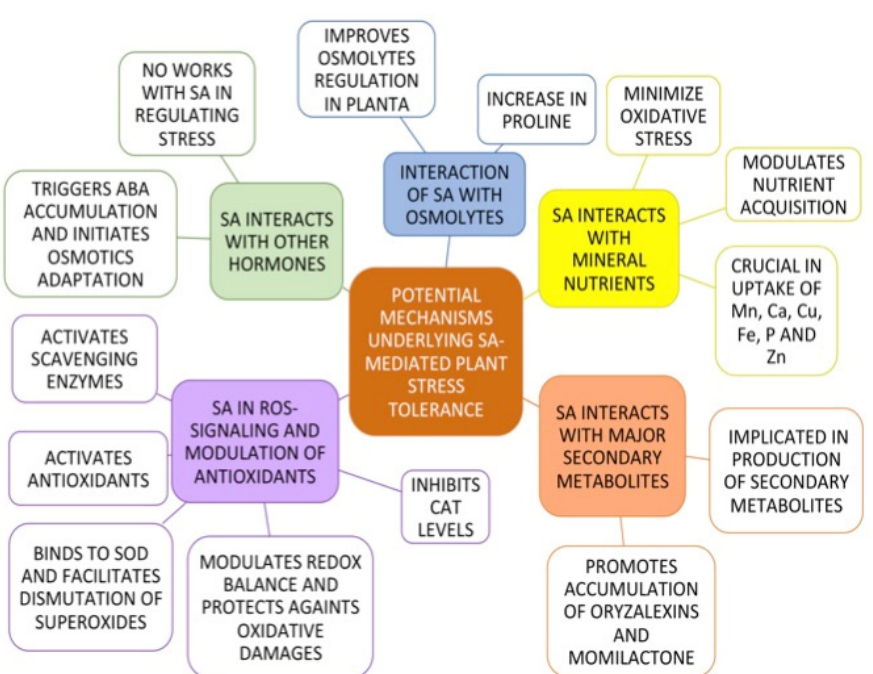
Figure 2. A schematic representation of the mechanisms utilized by SA in regulating stresses in